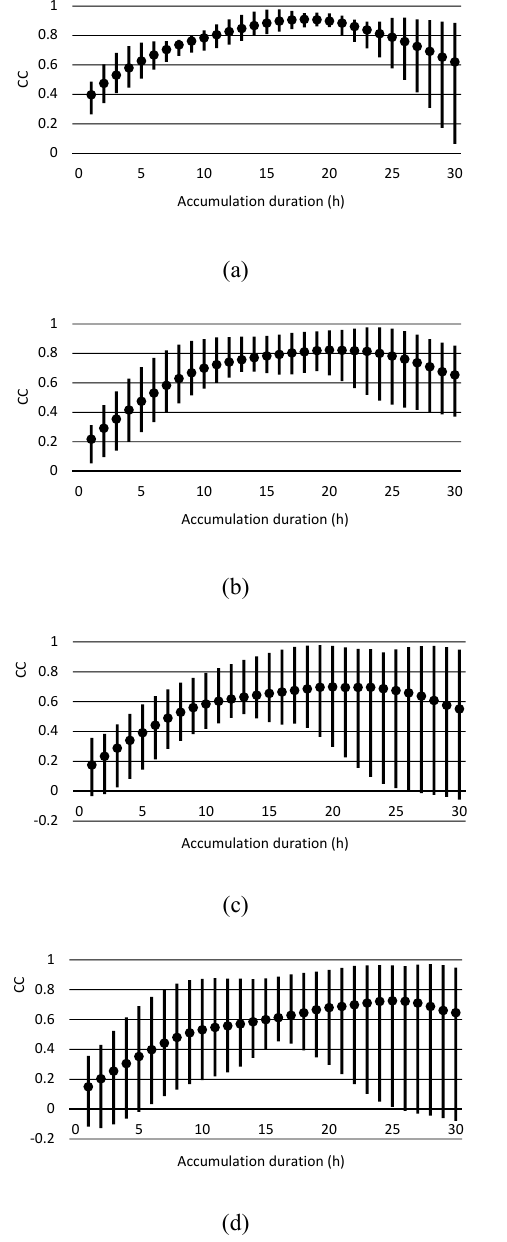
Figure 4. Cross-correlations between water level and cumulative rainfall with various time lags (10 min per lag): (a) Zhongnanxing station; (b) Xinnan station; (c) Sijie station; (d) Meifu station (cor- relation coefficient less than -0.2 is not